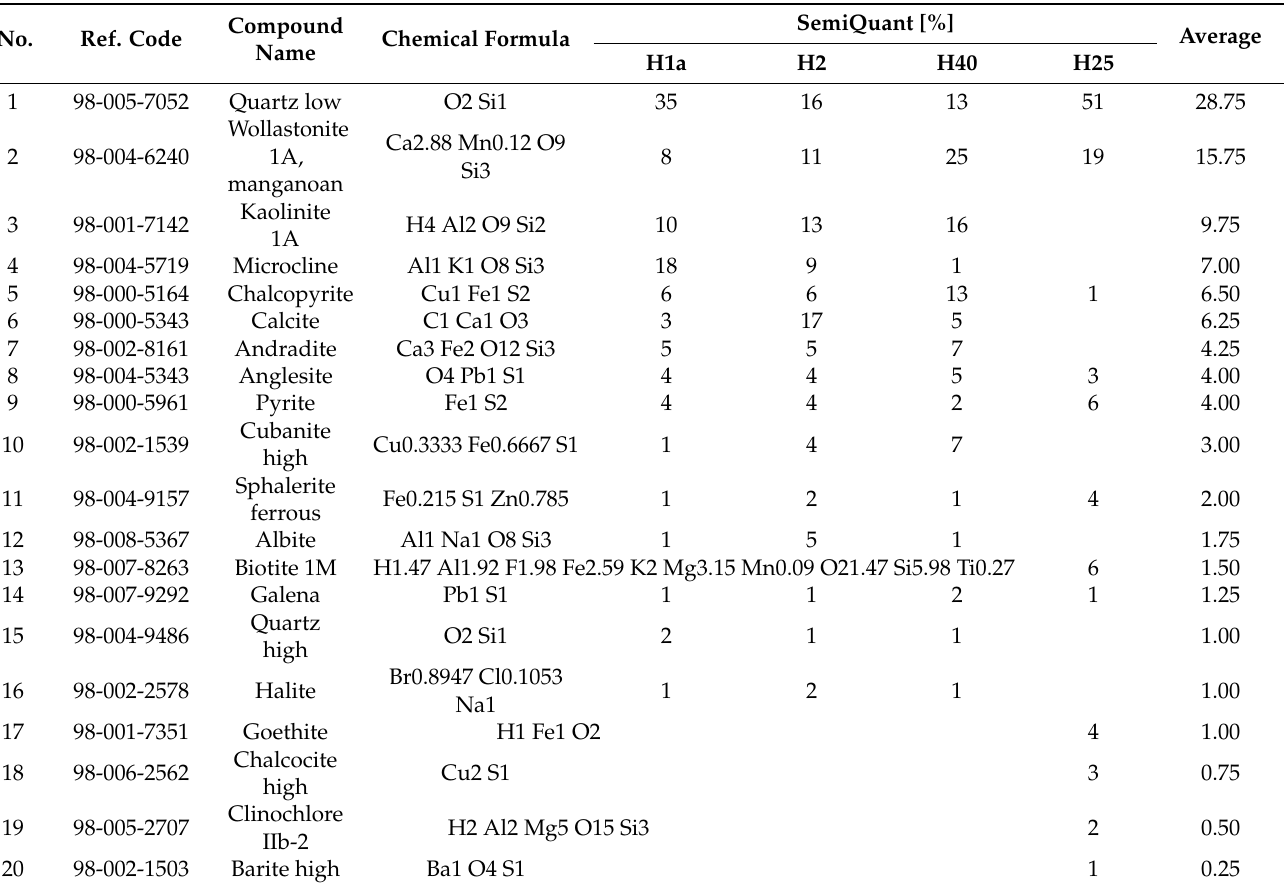
Table A1. XRD analyses of representative samples from the ore